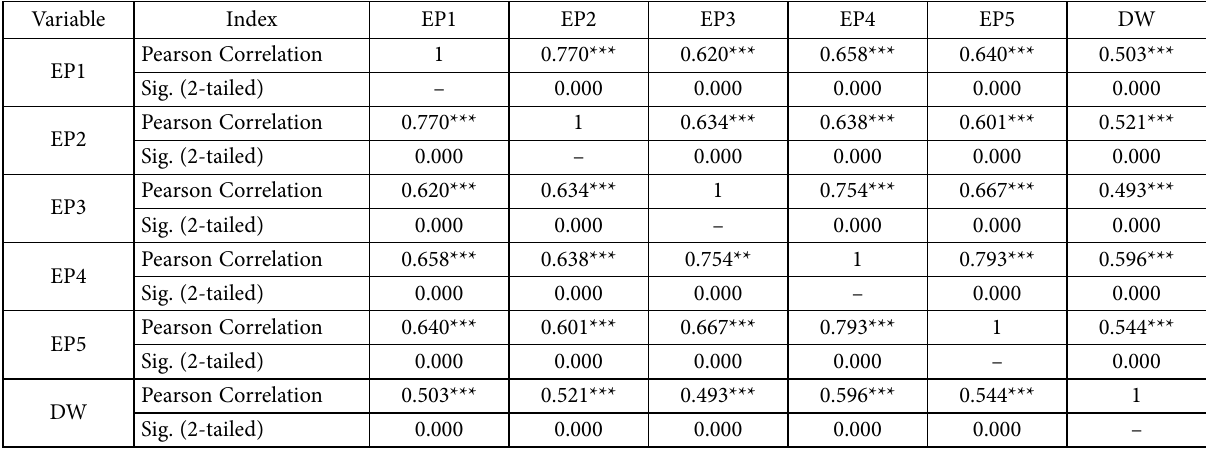
Table 17. Correlation analysis of environmental policy and the developers’ willingness to implement